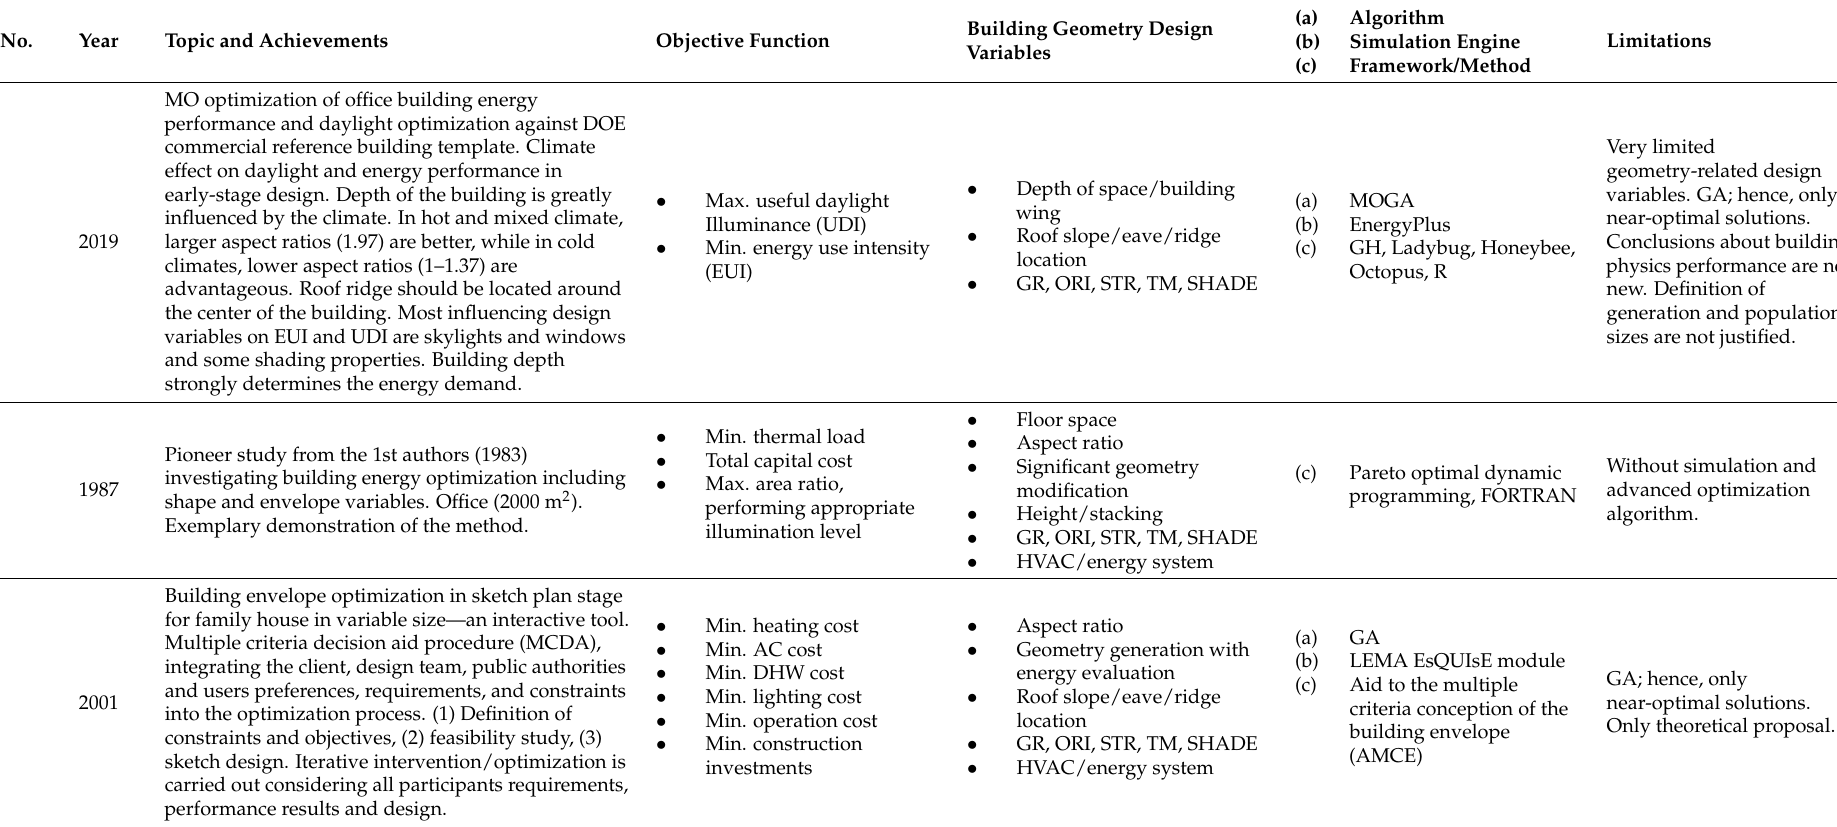
Table 1. BECEDO research using basic building shape design